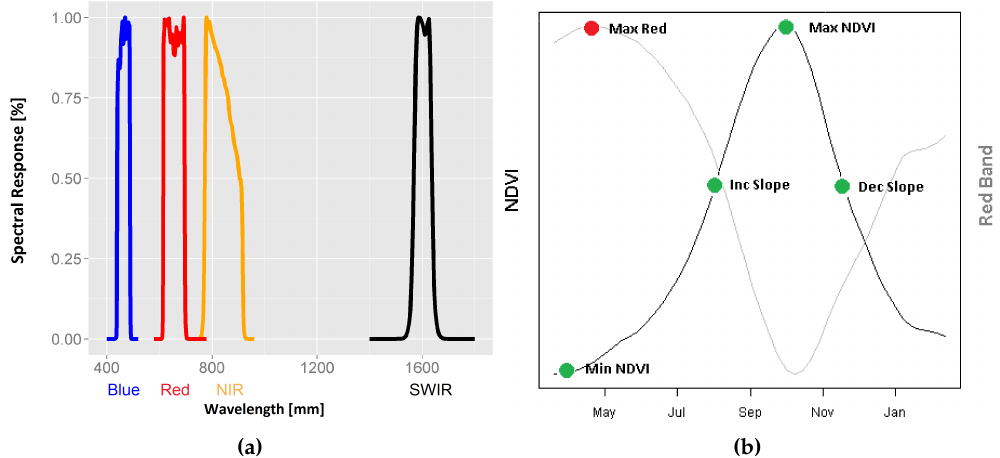
Figure 7. ( a ) Spectral response of the four bands (blue, red, NIR, SWIR) of the PROBA-Vegetation instrument; ( b ) Representation of the five temporal features (minimum NDVI, maximum NDVI, increasing slope, decreasing slope and maximum